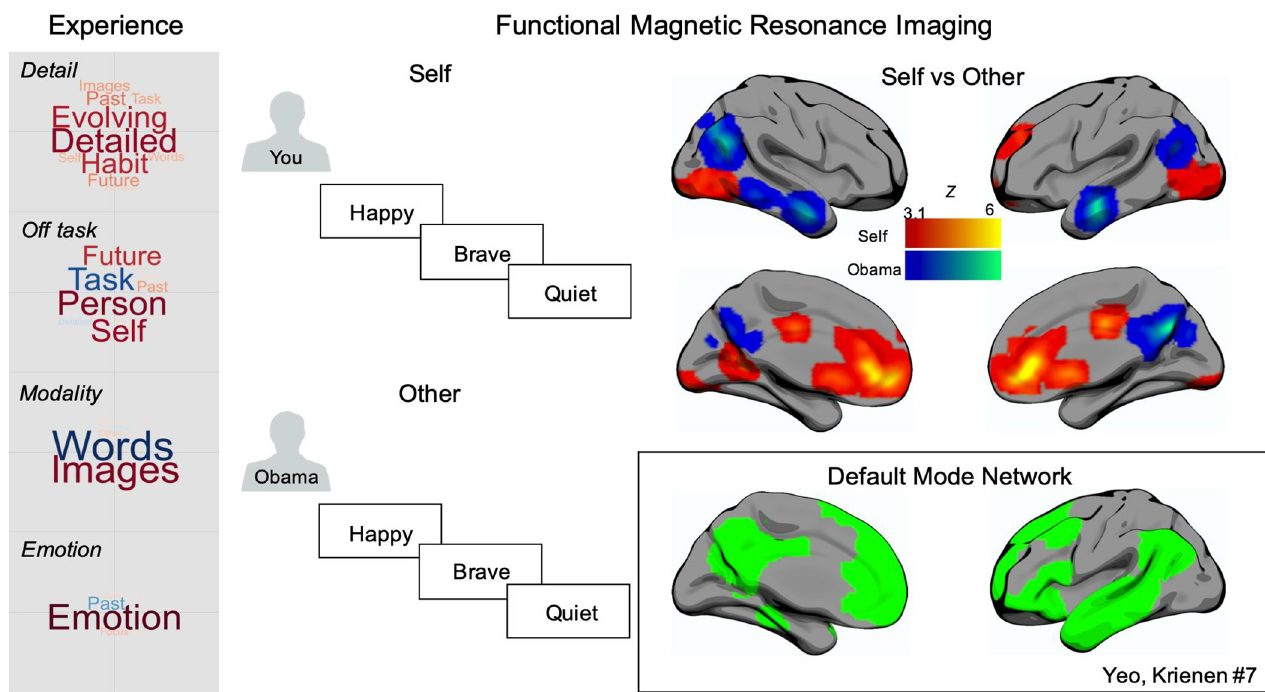
Fig 2. Patterns of thought during the laboratory and the modulation of neural activity during the self-reference task. The panel on the left-hand side displays the components of thought determined by the application of Principal Components Analysis to the Multi-Dimensional Experience Sampling (MDES) using a sample of 207 individuals. The size of the word describes the strength of the loading and the colour identifies whether the loadings is positive (warm) or negative (cool). The central panel describes the block design used to assess neural processing during a self-reference task in the scanner. The brains display the spatial distribution of the regions identified through a contrast of activity between Self and Other referent conditions. Warm colours highlight regions showing more activity during Self judgements compared to Others, and cool colours show regions showing more activity in Other (Obama) judgements compared to Self. The spatial maps are thresholded at Z = 3.1 and are controlled for multiple comparisons (p < .05, FWE). The box in the lower right hand corner shows the DMN as defined in the 7-network solution [37].